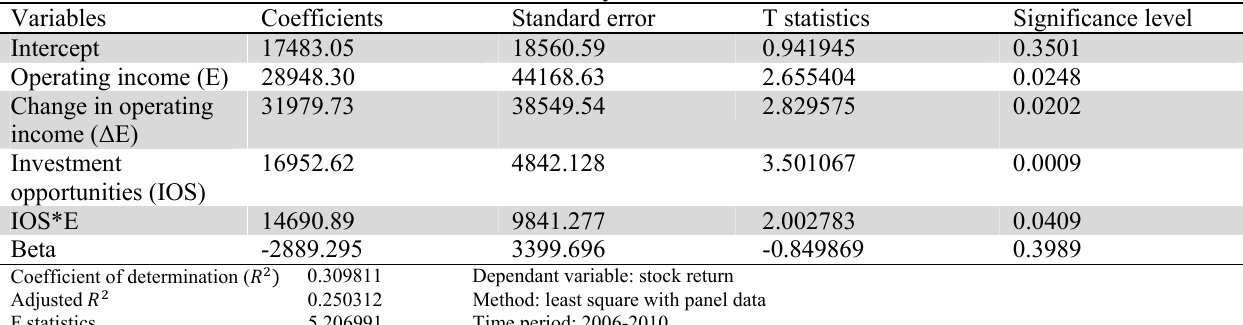
Model estimation results for firms with low life cycle score